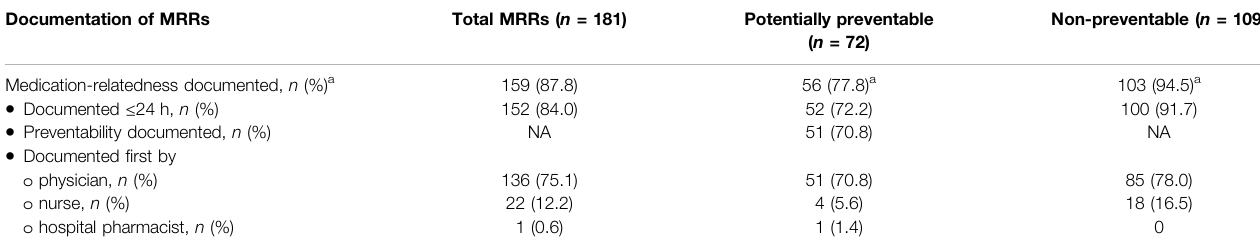
TABLE 2 | Documentation of potentially preventable and non-preventable medication-related readmissions (MRRs) in patient records. Documentation of